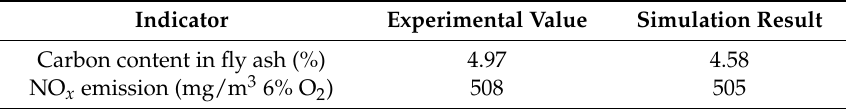
Table 3. Some indicators at the furnace outlet under the in-situ test and simulation results.